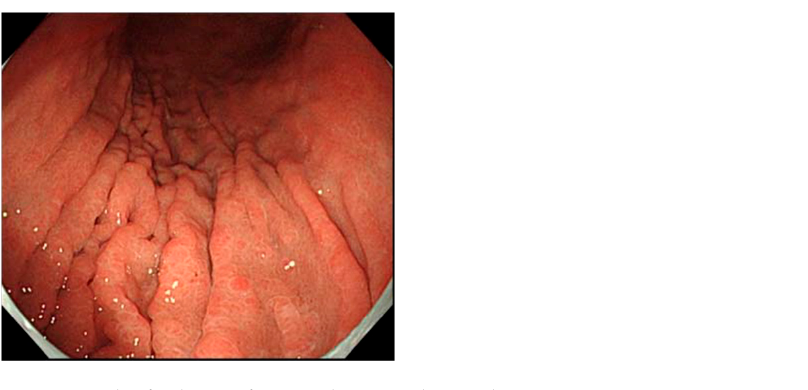
Figure 11. The findings of a case diagnosed as early AIG. It presents a mosaic pattern consisting of swollen gastric areas in the